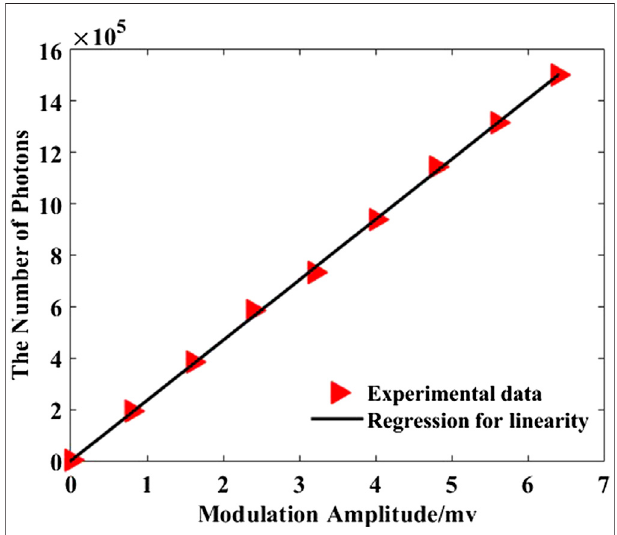
FIGURE 6 | Measured dynamic range of the DOT